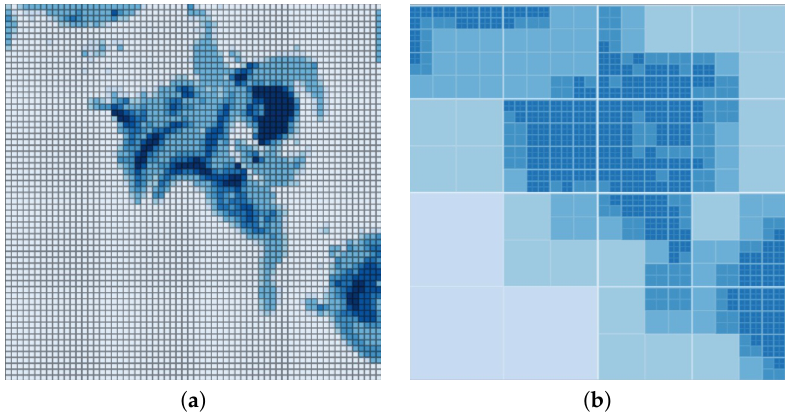
Figure 7. Visualization of the canyon flooding using ( a ) regular grids, ( b ) adaptive